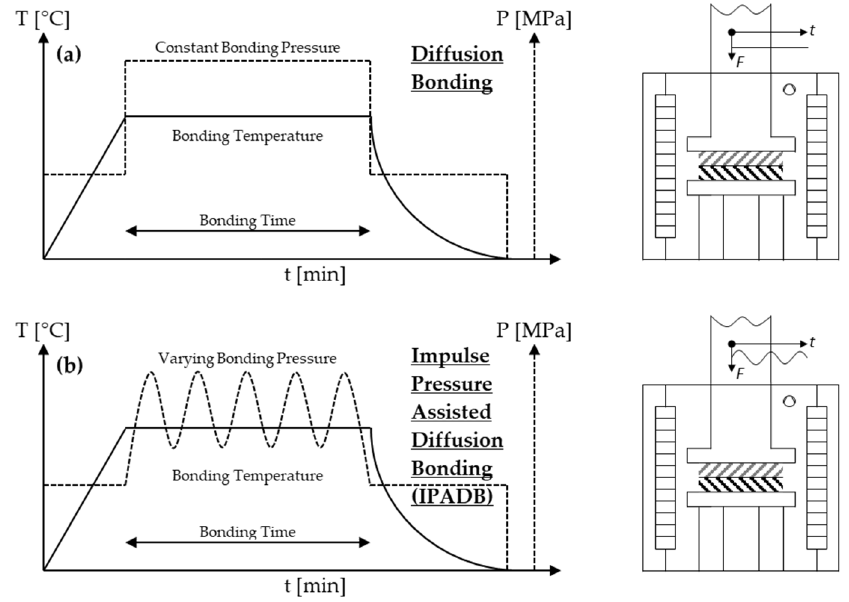
Figure 2. Schematic comparison of bonding temperature and -pressure during the traditional diffusion bonding process ( a ) and impulse pressure diffusion bonding (IPADB) ( b ).